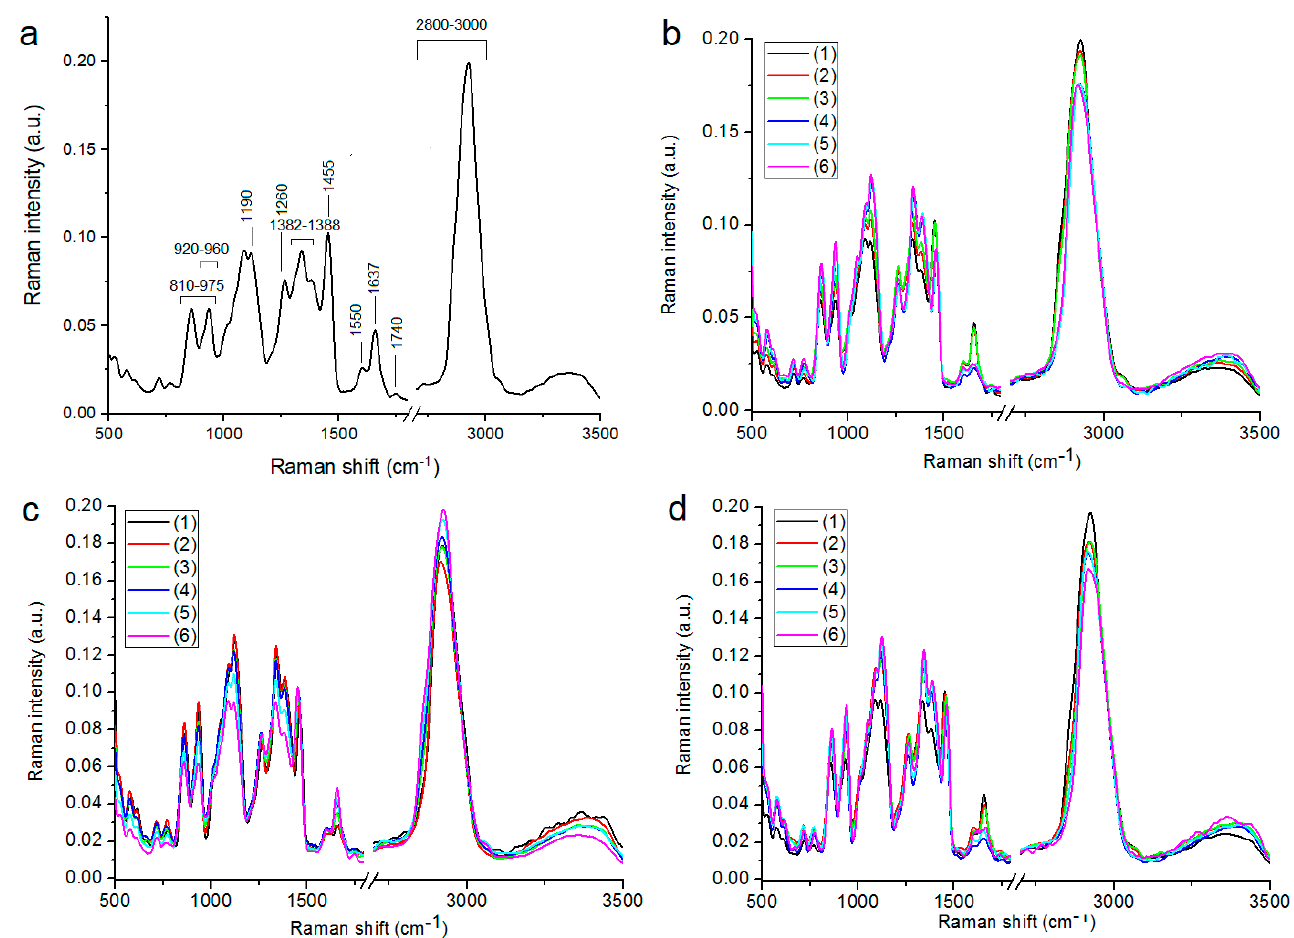
Figure 2. FT-Raman spectra with marked analyzed region ( a ) for wheat grown in 2017 ( b ), 2018 ( c ), and 2019 ( d ); crop protection variants: (1) control (black line); (2) intensive (red line); (3) extensive (green line); (4) PlanTonic BIO (blue line); (5) PlanTonic BIO + Natural Crop (azure line); (6) PlanTonic BIO + Biofol Plex (pink